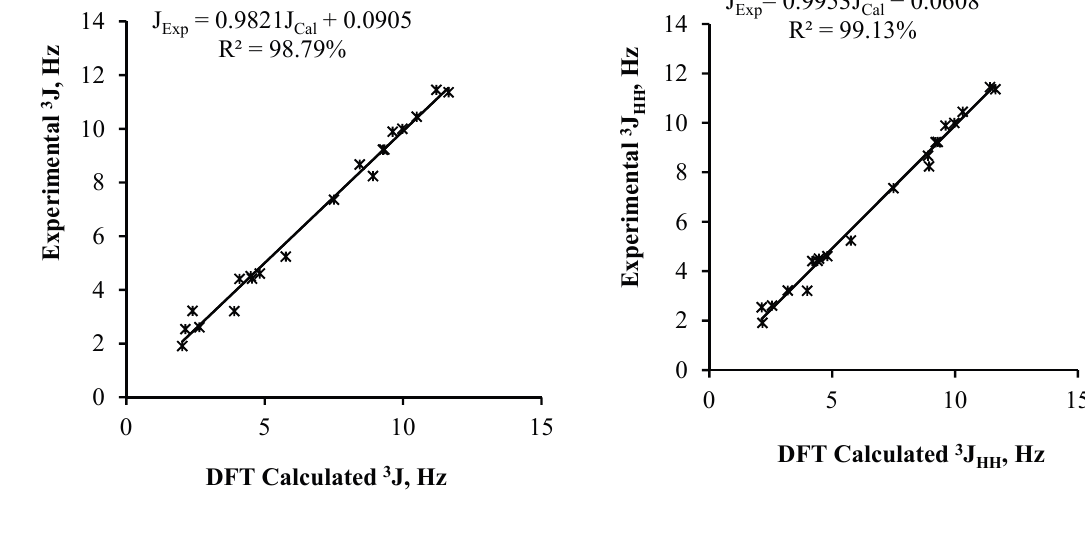
coupling constants for 2a and 2b . HH